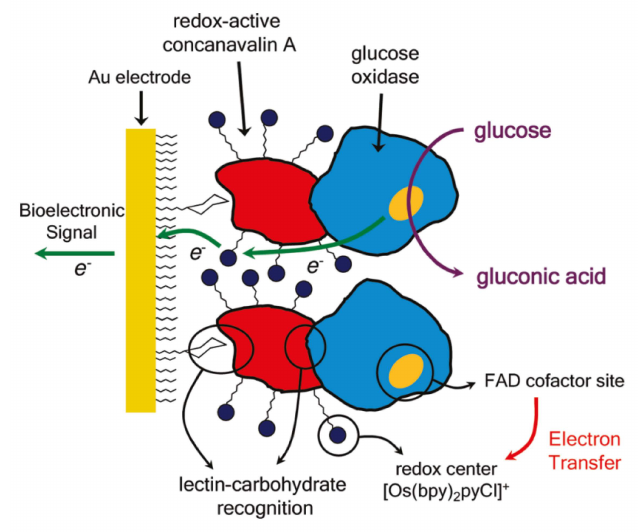
Figure 2. A glucose sensor based on redox-active Con A and GOx. Reprinted with permission from Langmuir. Copyright 2010 American Chemical Society [59].